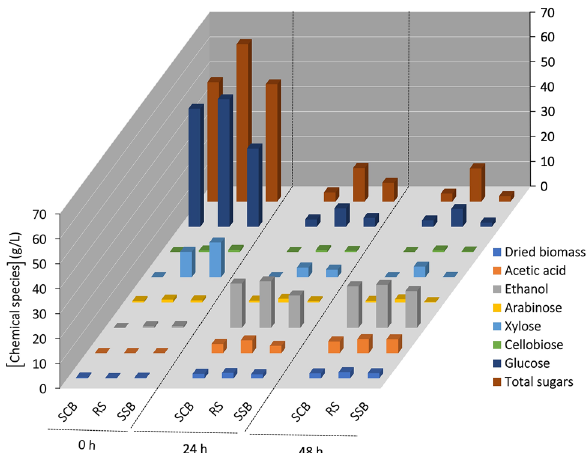
Figure 1. Kinetic profiles of total sugars, individual sugars (cellobiose, glucose, xylose and arabinose), ethanol, acetic acid and dried biomass concentration levels during cultivation of C. tropicalis TISTR 5306 on different